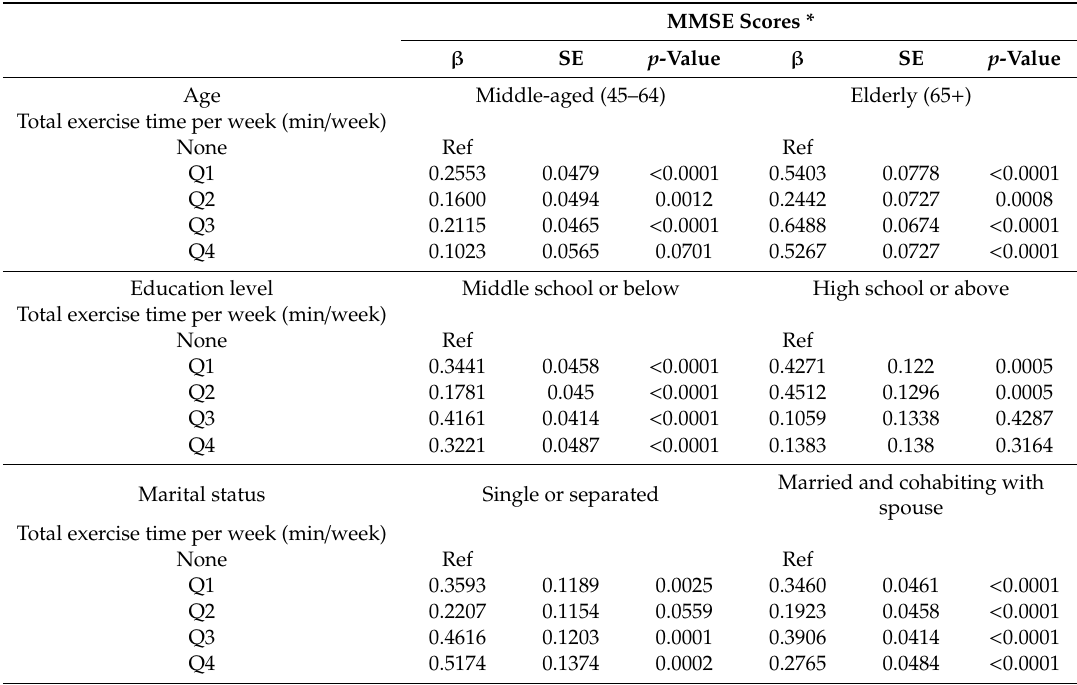
Table 4. Results of the subgroup